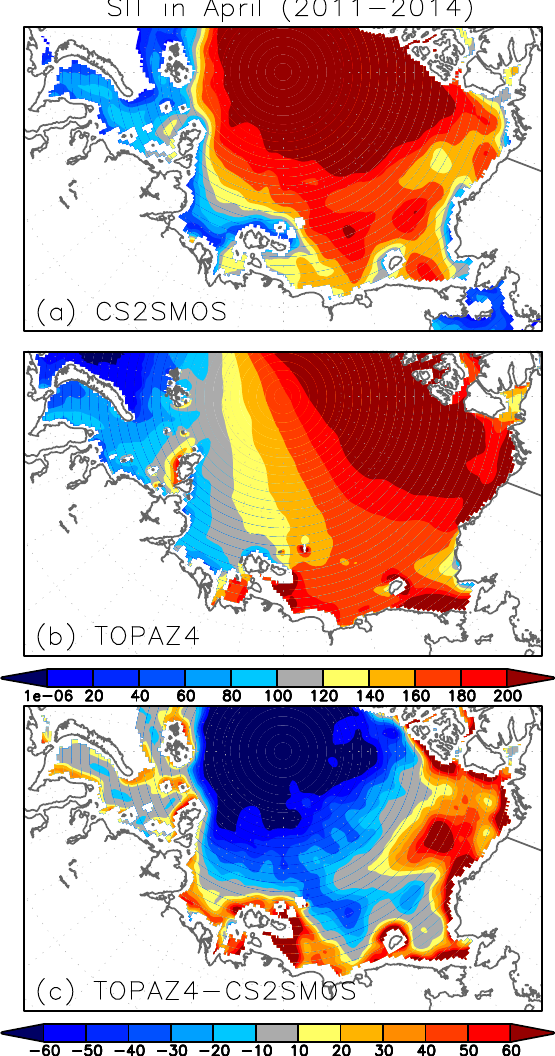
Figure 2. Spatial distribution of climatological monthly mean of SIT (centimetres) in April during 2011–2014: (a) CS2SMOS, (b) TOPAZ4 reanalysis and (c) their difference (centimetres).